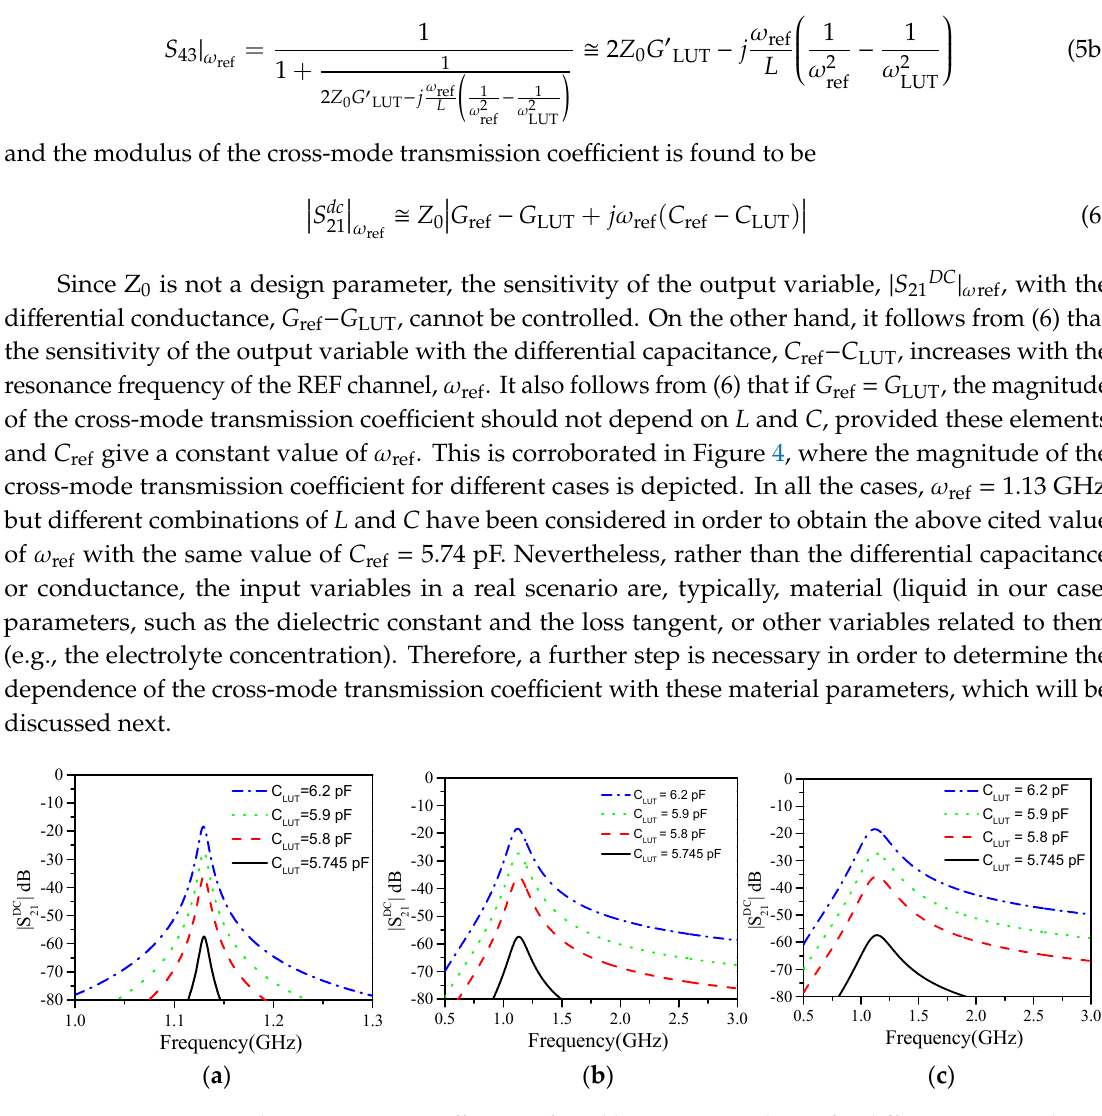
Figure 4. Cross-mode transmission coefficient inferred by circuit simulation for different cases, and the indicated values of C LUT . (a) L = 0.1 nH, C = 192.63 pF; (b) L = 1.7 nH, C = 5.93 pF; (c) L = 2.9 nH, C = 1.10 pF. In all the cases, C ref = 5.74 pF and G’ ref = G’ LUT = 1.489 mS.